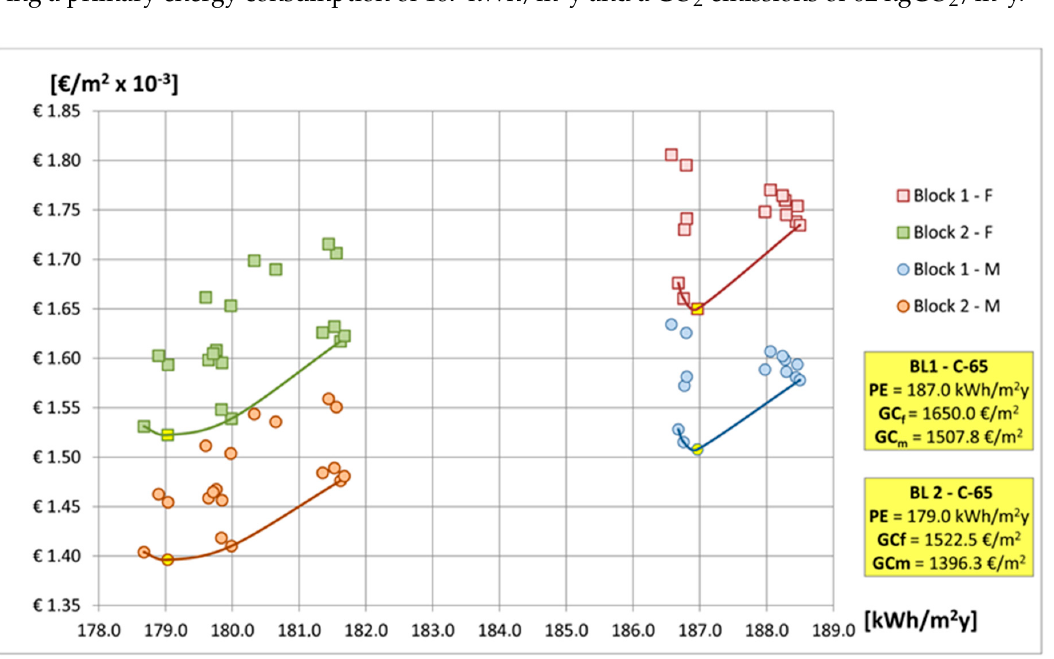
Figure 2. Cost-optimal level and best solutions for reference building 1.